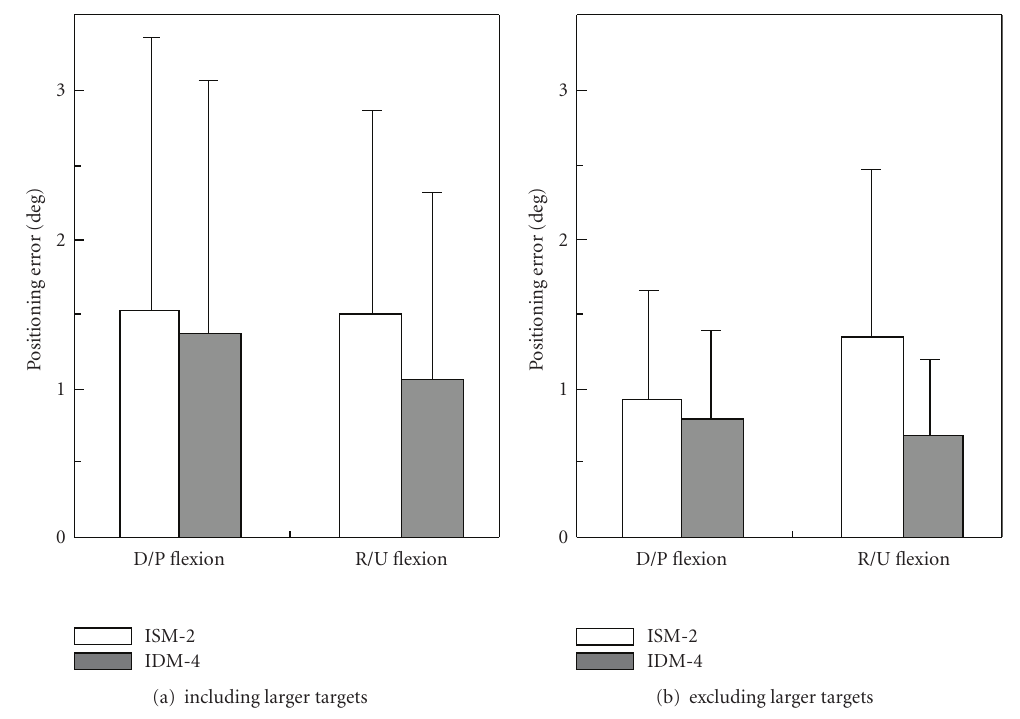
Figure 6: Evaluation results of ISM learning in positioning